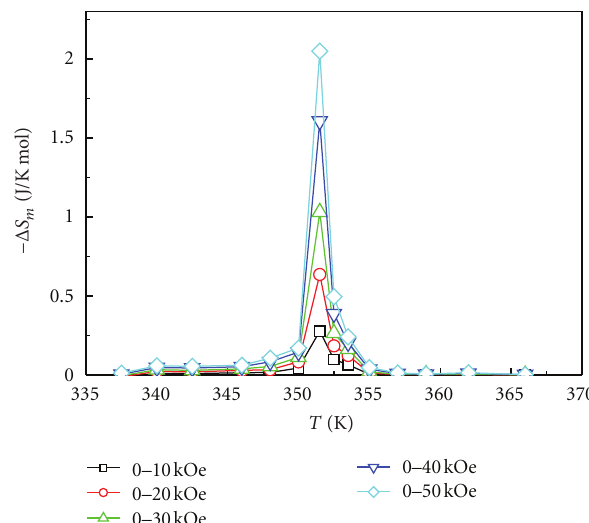
F 4: Temperature dependence of the magnetic entropy change whenthemagnetic�eldchangesfrom0to10,20,30,40, and50kOe,